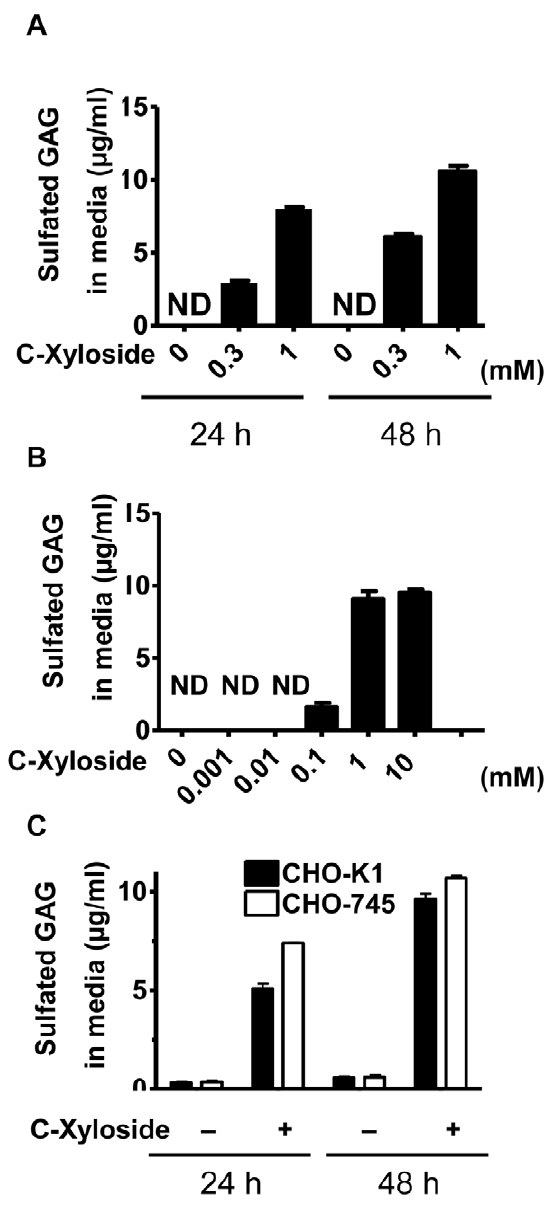
Figure 1. C-Xyloside induces sulfated GAGs from NHEK in culture media without the involvement of Xylosyltransferase. Primary keratinocytes were stimulated with PBS (untreated cells) or C- Xyloside (0.3 mM or 1 mM). (A) Cultured media were collected after 24 and 48 hours. Total sulfated GAG was determined by Blyscan assay. (B), Increasing concentrations of C-Xyloside were added to keratinocytes. Culture media was collected after 24 hours and total sulfated GAG was determined by Blyscan assay. (C), CHO-K1 (black bars) and CHO-745 (white bars) cells were cultured in the presence or absence of C- Xyloside (1 mM) for 24 hours and the amount of sulfated GAG in the media was determined by Blyscan assay. Data are representative of three individual experiments, and presented as mean 6 SEM (n=3). N.D., not detected.